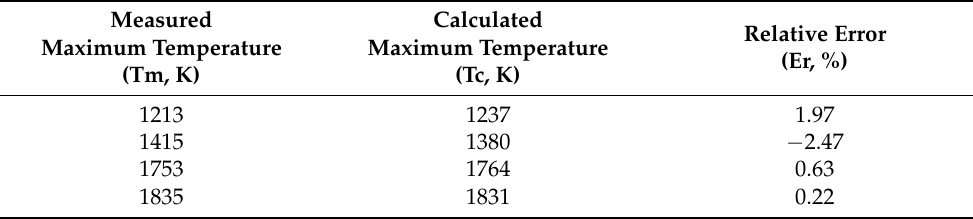
Table 1. Comparison of Measured and Calculated Temperature.